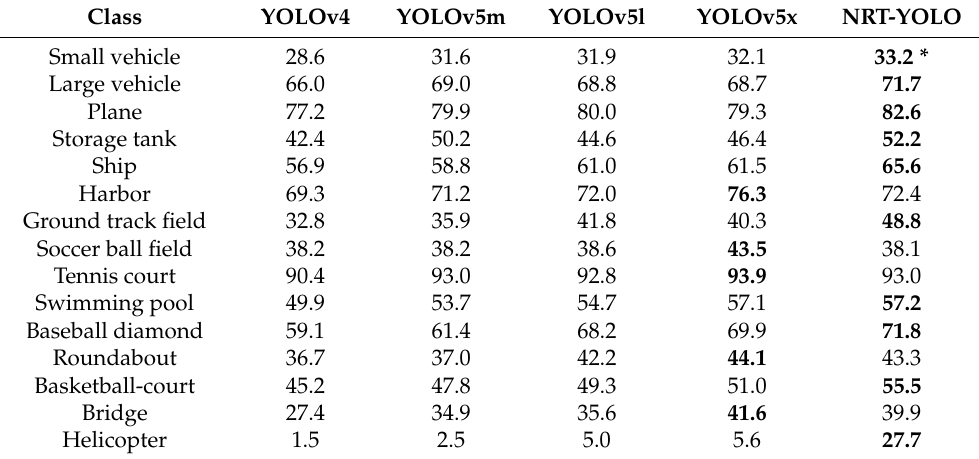
Table 1 details the results of different metrics of the five object detection